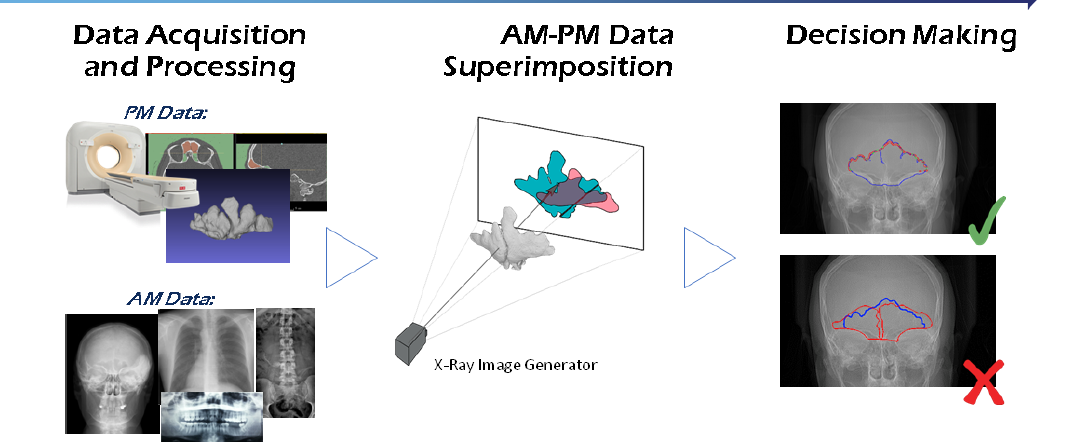
Figure 3. General comparative radiography (CR)-based ID process. After data acquisition and processing (e.g., anatomical regions of interest segmentation), and prior to decision